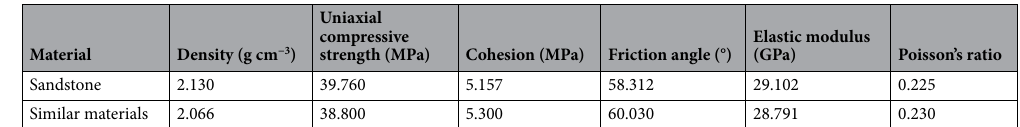
Table 4. Mechanical parameters of sandstone and similar materials 72 .